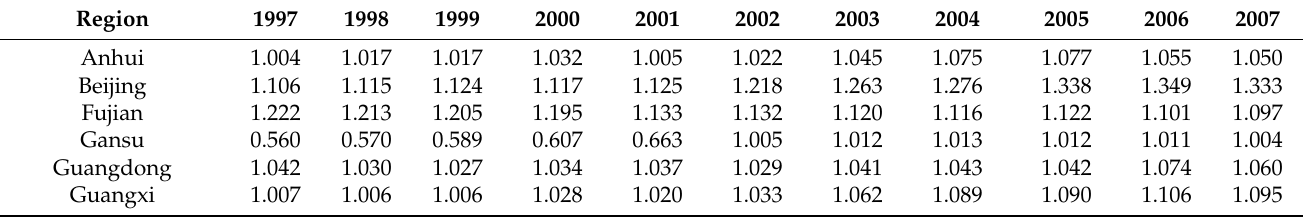
Table 5. Ecological well-being performance of 30 provinces, four regions and eight regions in China: 1997–2018.